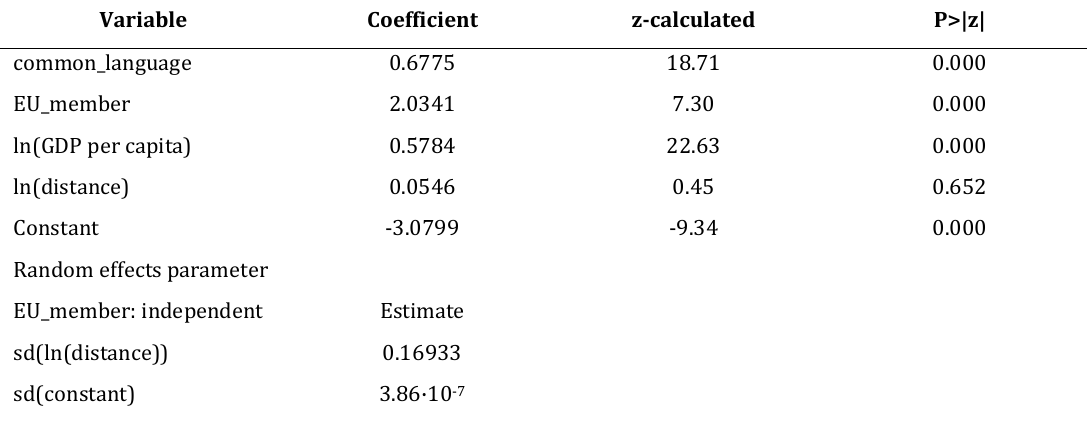
Table 3: Mixed-effects Poisson model (M2) for explaining the number of FDI projects in the UK